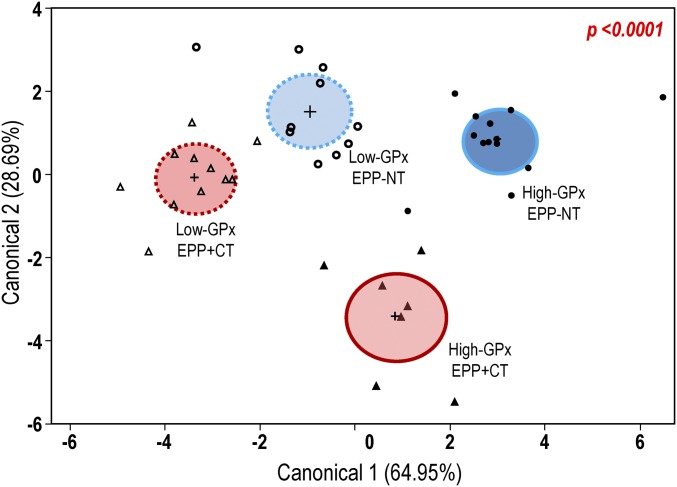
LDA was applied to the biochemical (GR activity, active Trx levels, and oxidized Prx levels), neuroanatomical (right and left hippocampal volume), and clinical (MATRICS Consensus Cognitive Battery t scores, positive symptoms, negative symptoms, disorganized symptoms, and depressive factors) data. The scatterplot diagram illustrates individual values of the first two canonical axes of the model, group means (+), and 95% confidence interval (ellipse). The canonical axes 1 and 2 of the model explained 64.95% and 28.69% of the variance, respectively. The four groups were significantly separated according to the four MANOVA tests: Wilks’ Lambda, Lawley’s trace, Roy’s largest root, and Pillai’s trace tests (P < 0.0001). EPP+CT, red; EPP−NT, blue; high-GPx, dark color; low-GPx, light color.